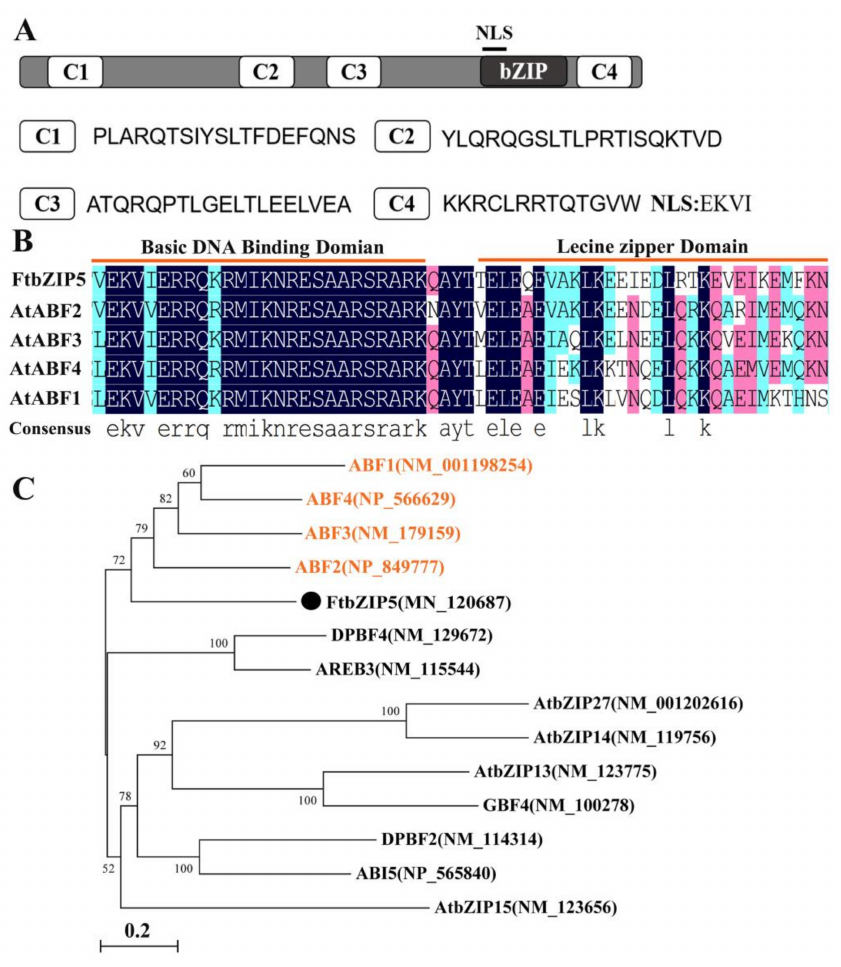
Figure 1. Structure and sequence analysis of FtbZIP5 protein. ( A ) The conserved domain of FtbZIP5 protein. C1, C2, C3 and C4, four potential phosphorylation sites; NLS, hypothetical nuclear positioning signal. ( B ) Sequence alignment of four AREB proteins related to stress resistance in Arabidopsis . ( C ) Results from the phylogenetic analysis of FtbZIP5 and members of subfamily A of bZIP transcription factors in Arabidopsis .